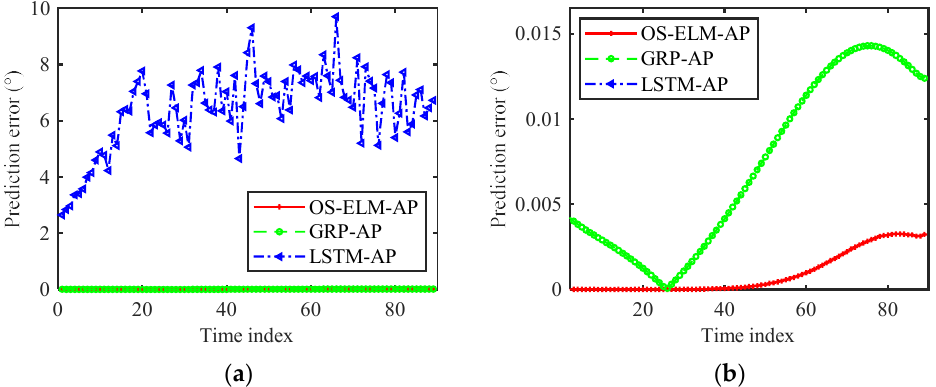
Figure 7. Online single-time interference angle prediction results. ( a ) Angle prediction error. ( b ) Magnified view of ( a ).